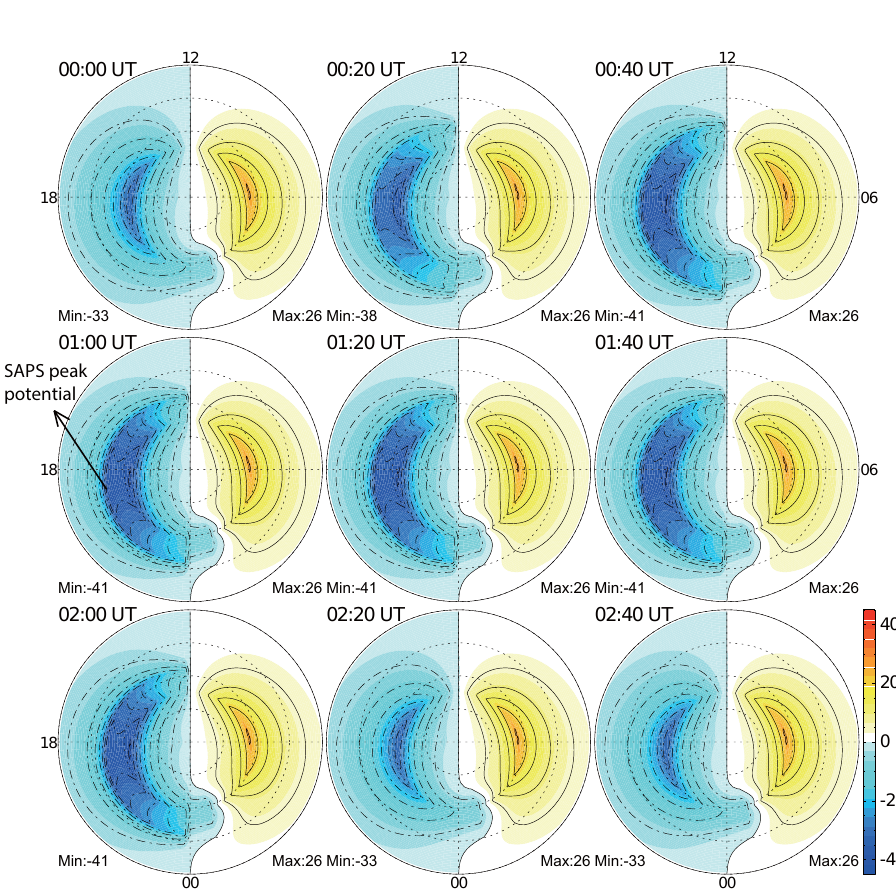
Figure 1. Geomagnetic latitude and magnetic local time variation of the ionospheric electrical potential. The outer ring represents 50 ◦ MLat. The substorm epoch time runs at 20min intervals from − 1h to 2h 40min. Noon is at the top of each panel. Midnight is at the bottom. Dawn is to the right and dusk to the left. SAPS potential is located 7 ◦ equatorward of the boundary of the auroral oval. SAPS potential increases linearly from 00:00 to 00:30UT, and then persists from 00:30 to 02:00UT. SAPS potential reaches a minimum of − 24kV around 19:00MLT, and decreases towards noon and midnight. SAPS potential is superimposed on the background potential in the subauroral region. The maximum and minimum potentials in the auroral and subauroral regions are shown at the bottom of each